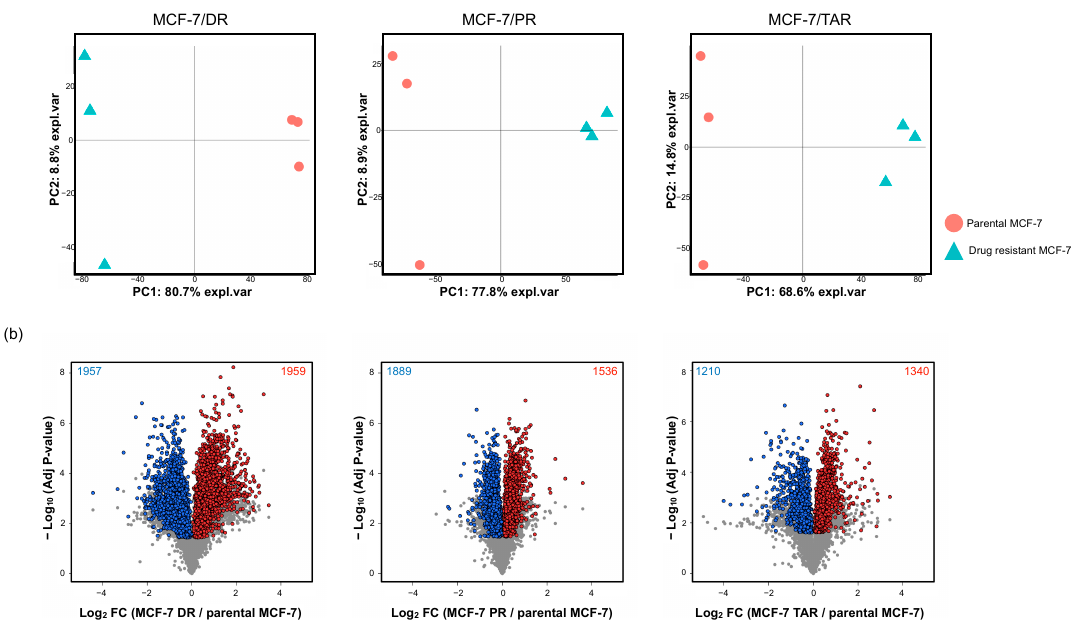
Figure 2. Analysis of differential protein expression with parental MCF-7 and drug-resistant MCF-7 breast cancer cell lines. ( a ) Principal component analysis of proteins quantified in each experimental set. The red spots represent parental MCF-7, and the blue triangle indicates drug-resistant MCF-7 cell lines of each of the three anti-cancer drugs. ( b ) Volcano plots of significantly different protein expression between parental MCF-7 and drug-resistant MCF-7. Volcano plots were drawn using TMT 6-plex data. Significant proteins had an FDR-adjusted p -value less than 0.05 for all comparison sets. Additionally, overlapped DEPs between TMT 6-plex and 10-plex datasets were plotted as the red spots (upregulation) and blue spots (downregulation).